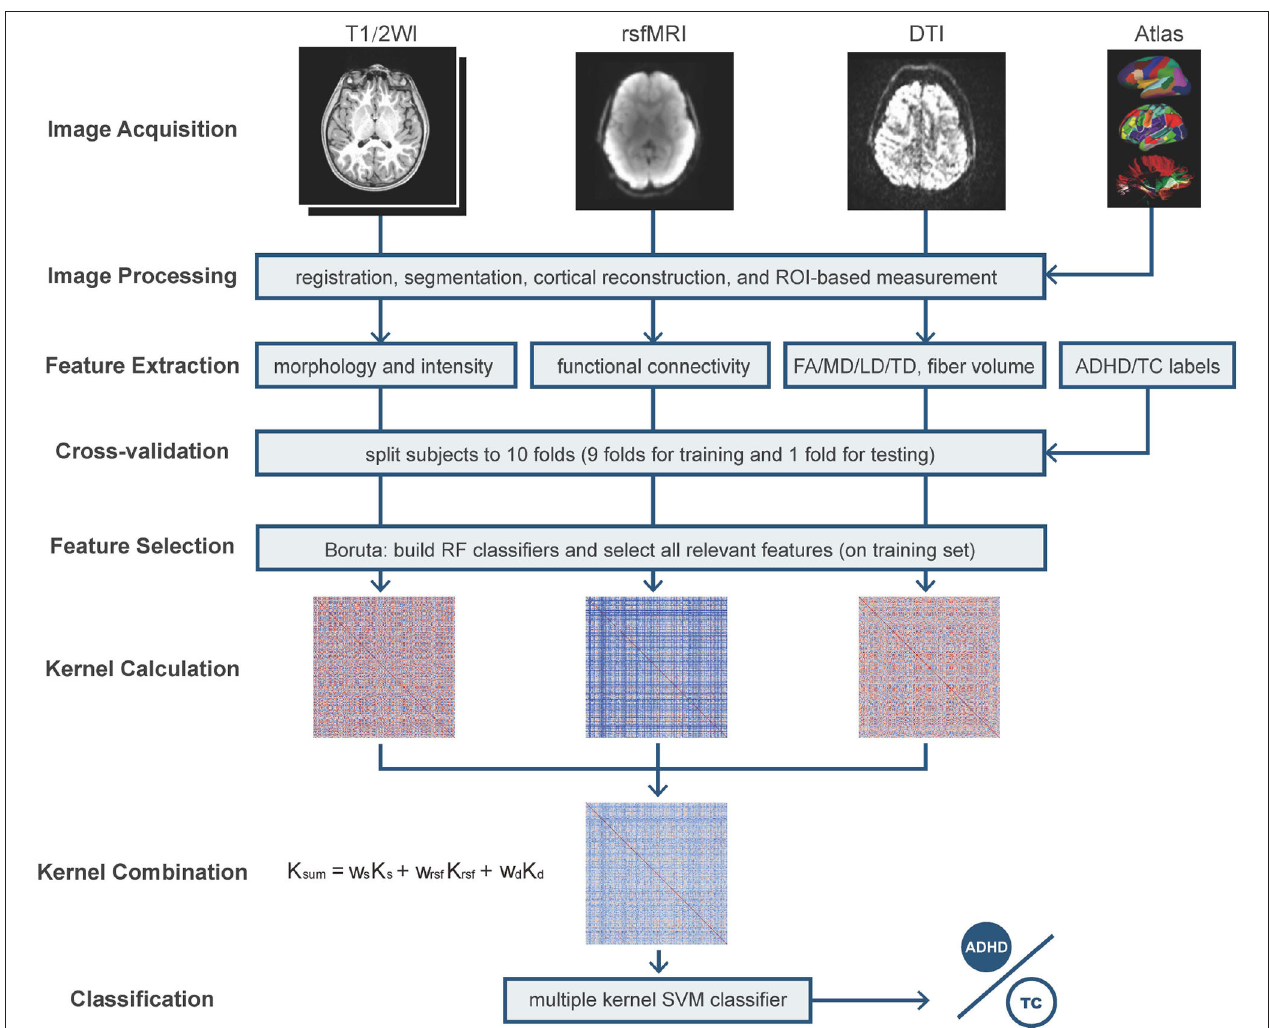
FIGURE 1 | The pipeline of feature extraction and cross-validation Multiple Kernel Learning (MKL) classification. T1/2WI, T1 weighted imaging and T2 weighted imaging; rsfMRI, resting-state fMRI; DTI, diffusion tensor imaging; FA, fractional anisotropy; MD, mean diffusivity; LD, longitudinal diffusivity; TD, transverse diffusivity; RF, random forest; SVM, support vector machine. The used atlases include Desikan–Killiany atlas, fuzzy-cluster parcels, subcortical regions, AtlasTrack, and Gordon parcellations; the morphological features include subcortical region volume, cortical volume, thickness, area, and sulcal